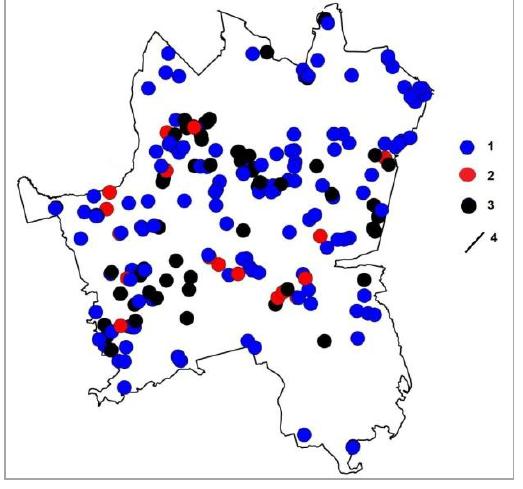
Fig. 4. Water reservoirs in Katowice